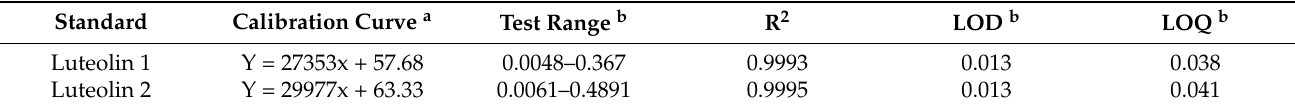
Table 5. Luteolin calibration curves, test range, limit of detection (LOD) and limit of quantification (LOQ) for HPLC analysis of Zostera marina